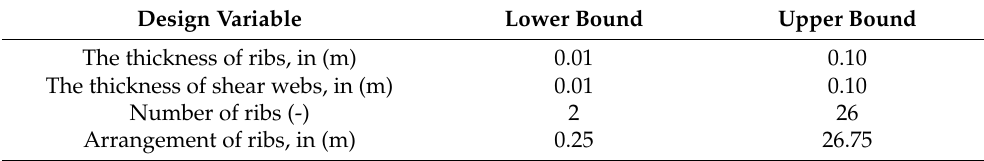
Table 3. The assumed in the proprietary program lower and upper bounds of the design variables.